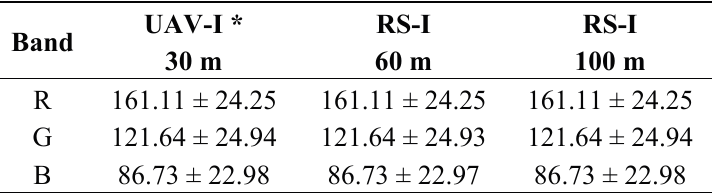
Table 3. Mean and Standard deviation of RGB-bands of UAV-image and RS-image created by Nearest-Neighbor